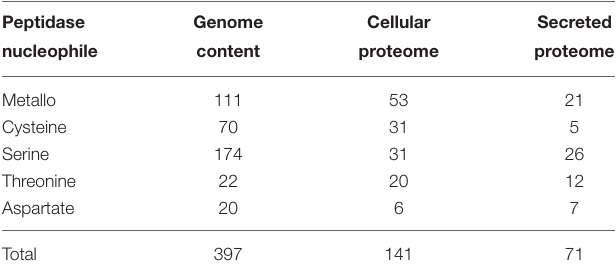
TABLE 2 | Peptidases identified from cellular and secreted proteomics data. Peptidase Genome